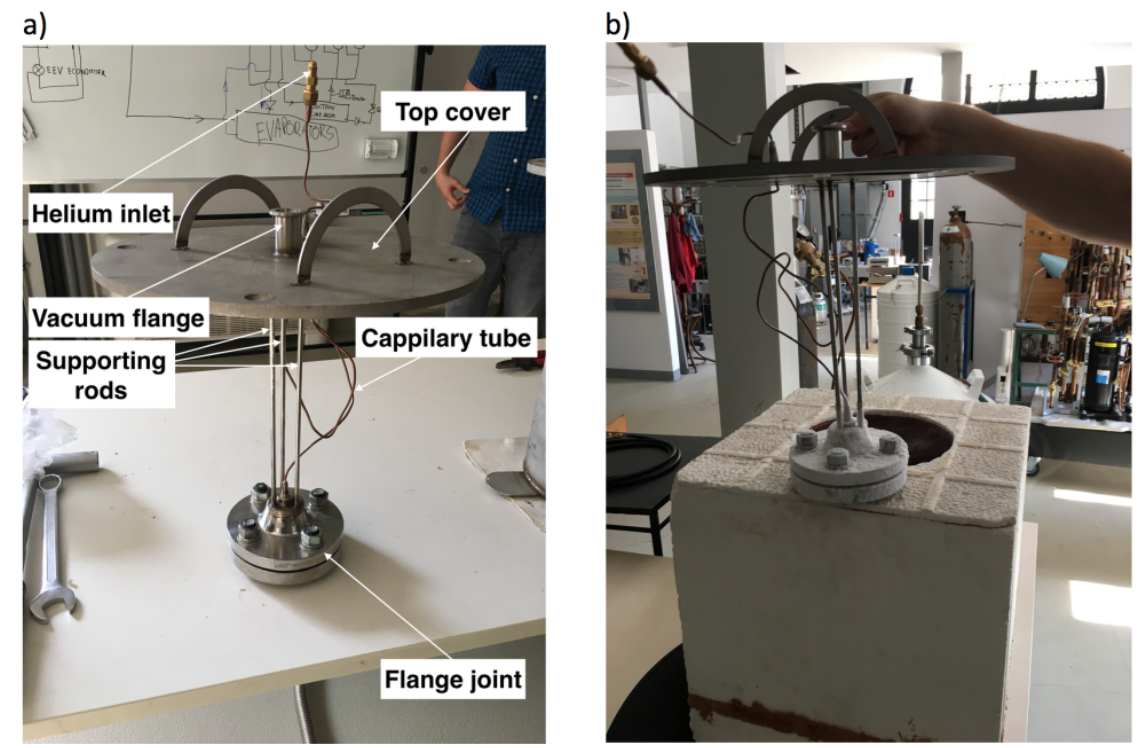
Figure 9: Tested flanged joint; a) before cooling, b) after cooling to 77 K.